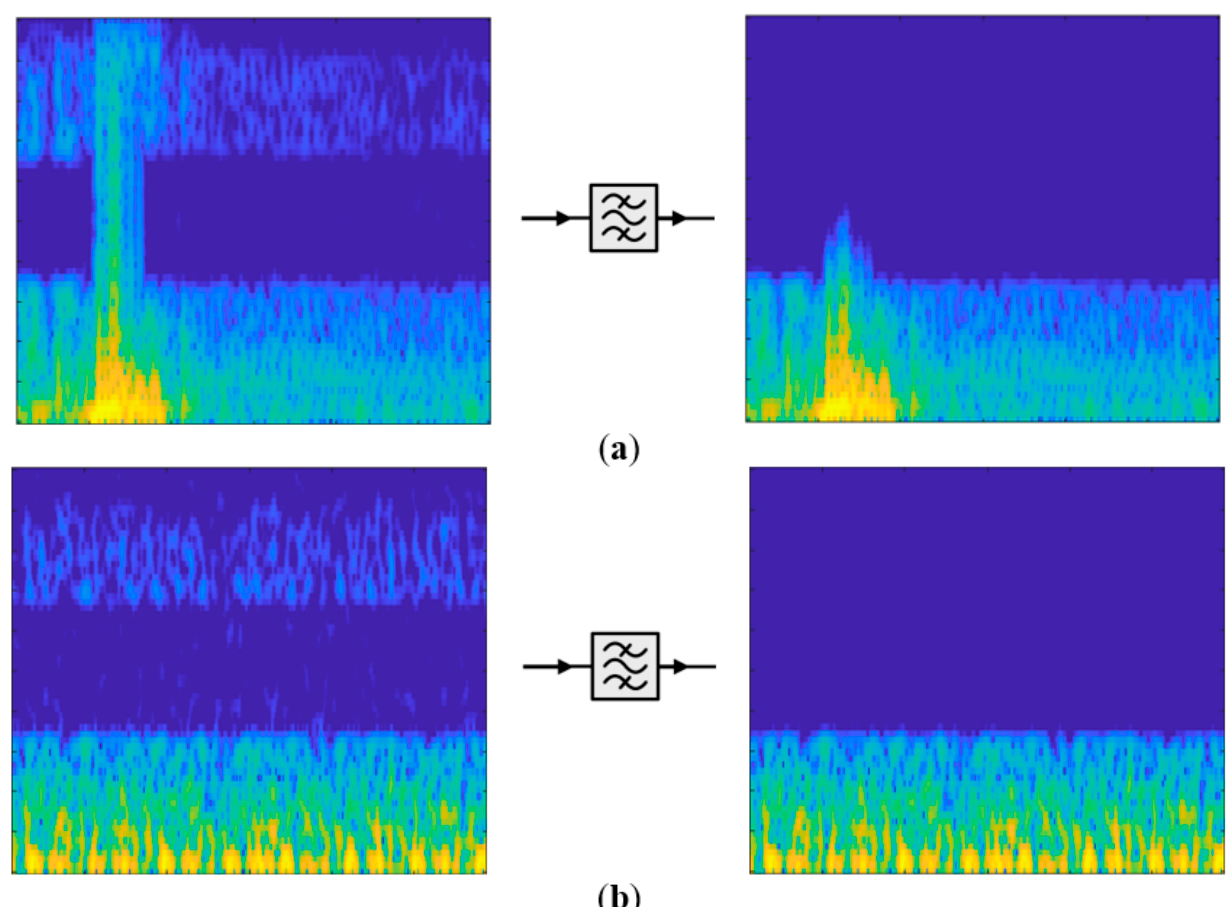
Figure 6. Examples of filtering effect: ( a ) HPT case example. ( b ) An NRT case example.